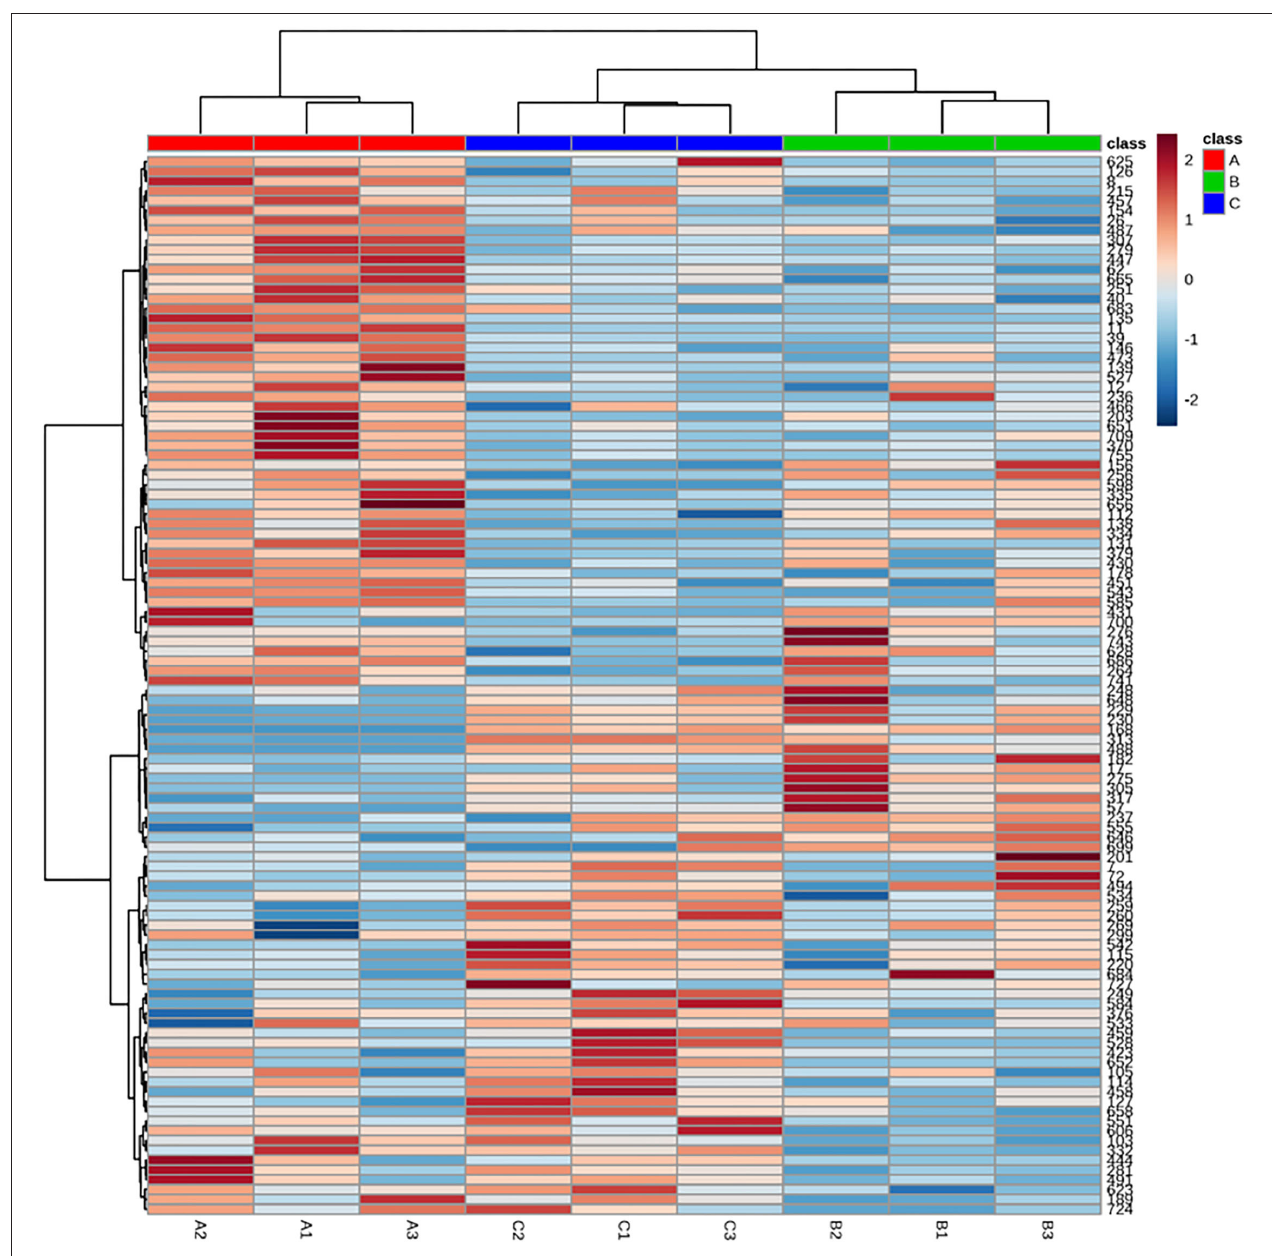
FIGURE 3 | Heat map of the hierarchical clustering analysis of differential chemicals among samples of fresh (A), steamed (B), and dried after steaming